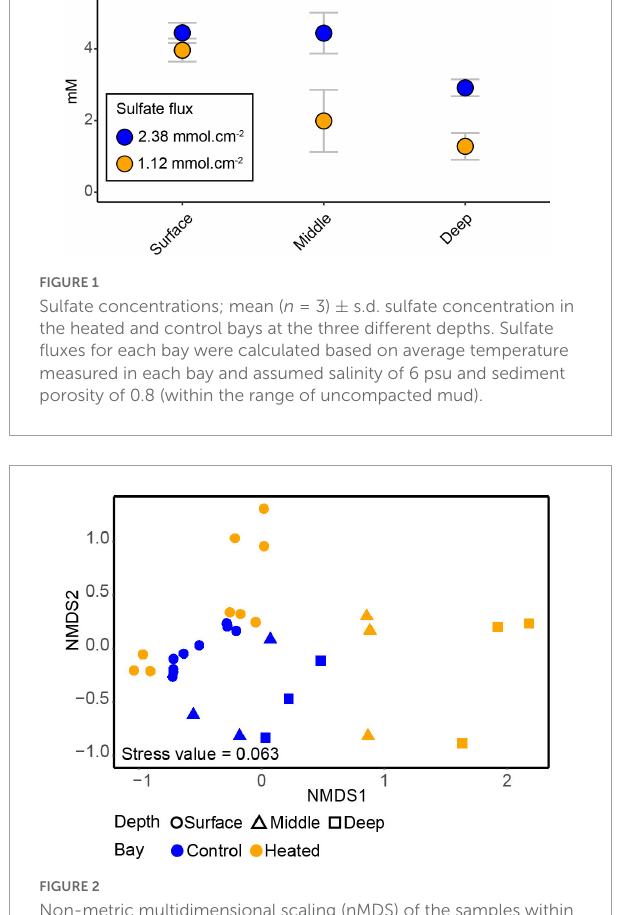
FIGURE2 Non-metric multidimensional scaling (nMDS) of the samples within the heated (orange) and control (blue) bays at the three different sediment